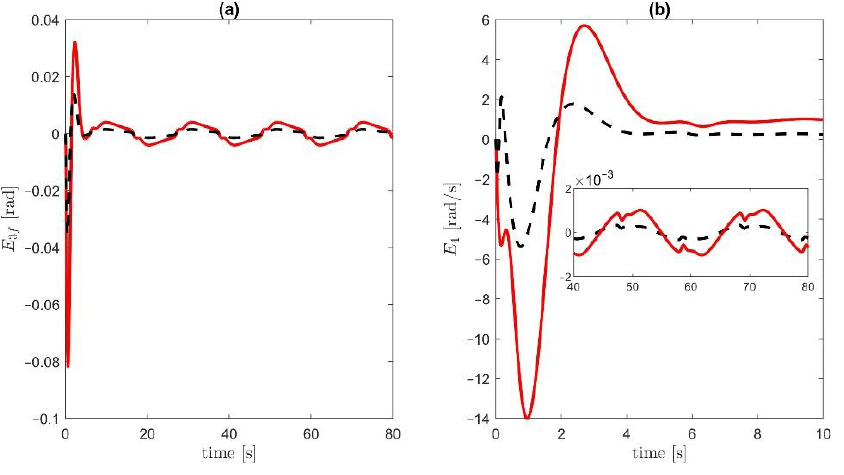
Figure 10. ( a ) Tracking error E 3 f , ( b ) tracking error E 4 . Dashed black line— k 1 = k 2 = k 3 = k 4 = 15, solid red line— k 1 = k 2 = k 3 = k 4 = 5.